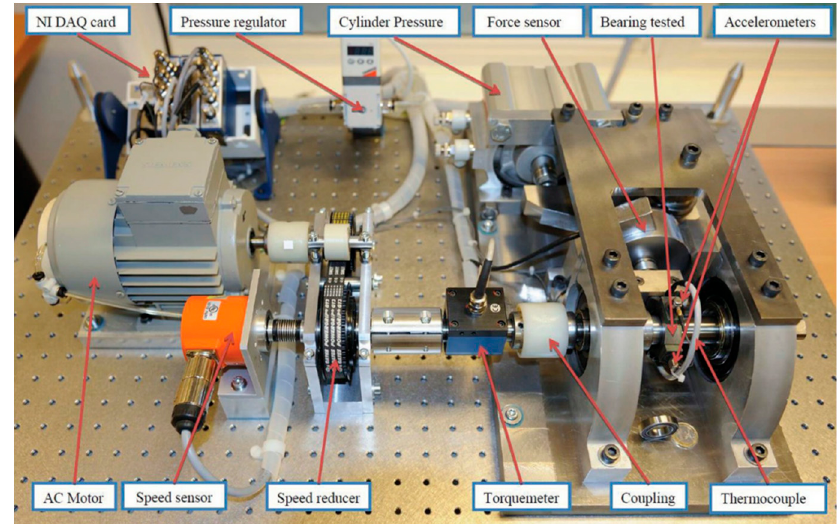
Figure 1. The PRONOSTIA platform [41].